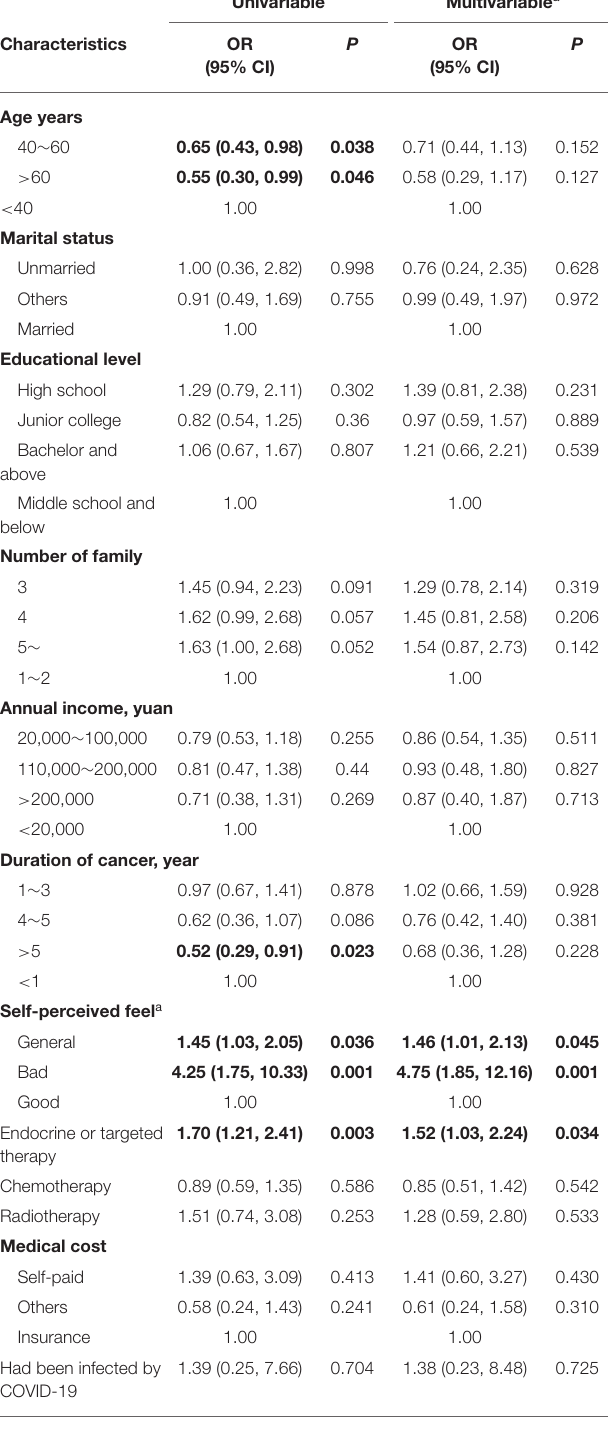
Univariable Multivariable a